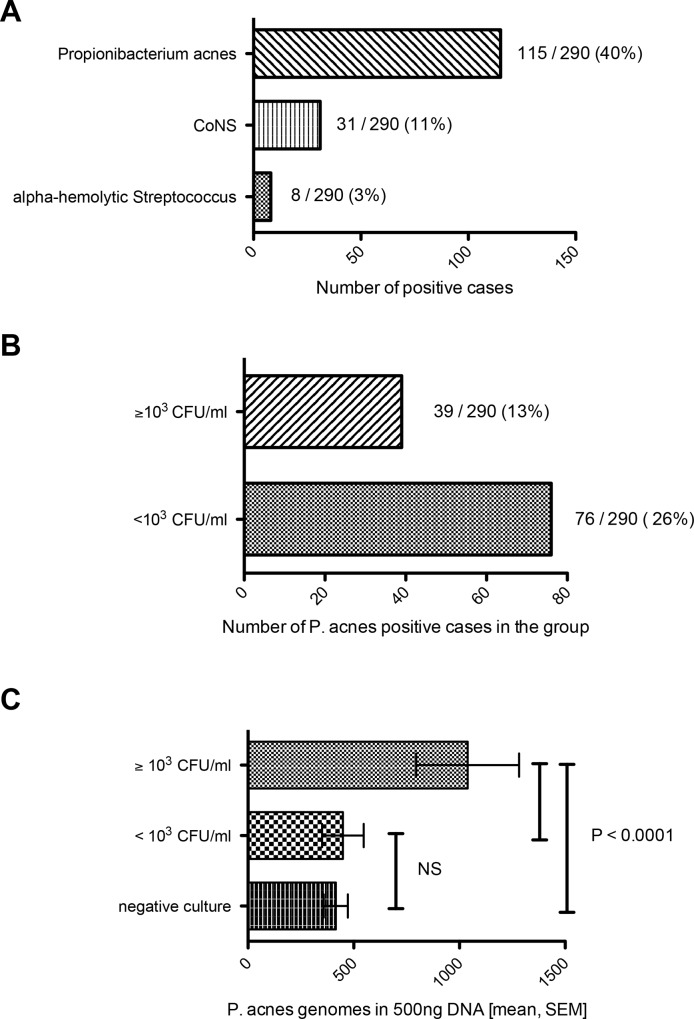
Results of anaerobic culture and detection of P. acnes genome counts in disc tissue samples.Prevalence rate of the bacteria isolated from disc tissue samples (A), stratification of the samples accordingly to bacterial counts reached by culture (B) and differences in the bacteria genome counts detected by real-time PCR in group of patients with abundant P. acnes by culture, non-abundant P. acnes and culture-negative cases (C).